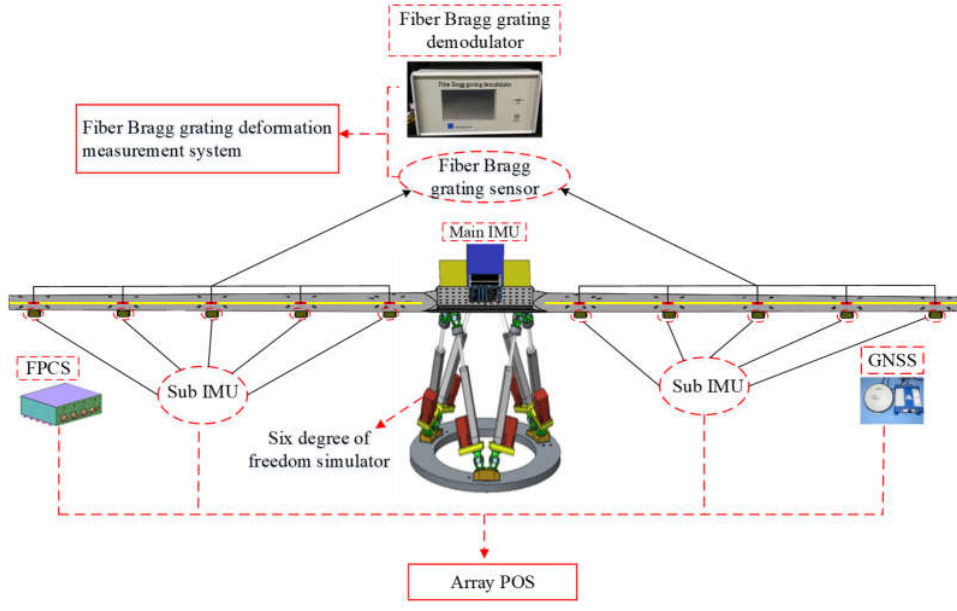
Figure 1. The diagram of the array POS system.